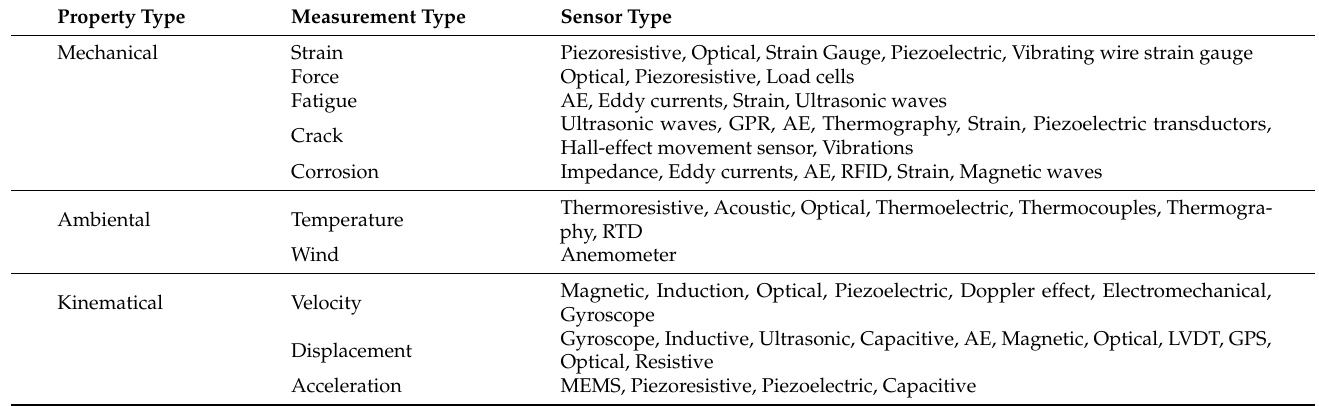
Table 17. Different types of sensors used for physical measurements in SHM systems classified by measurement type.